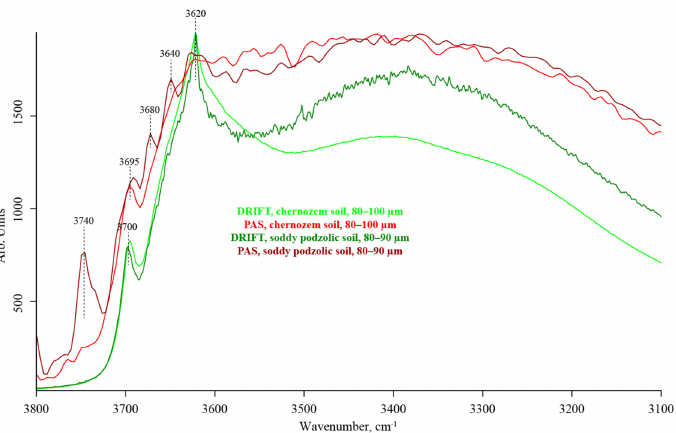
Figure 5. Normalized FTIR spectra in 3800–3100 cm − 1 . DRIFT and PAS (IMF, 1.6 kHz) spectra of shelterbelt chernozem soil (dry fractionation, 80–100 µ m), light green and light red, respectively; and DRIFT and PAS (IMF, 1.6 kHz) spectra of sod-podzolic soil (dry fractionation, 80–90 µ m), dark green and dark red,